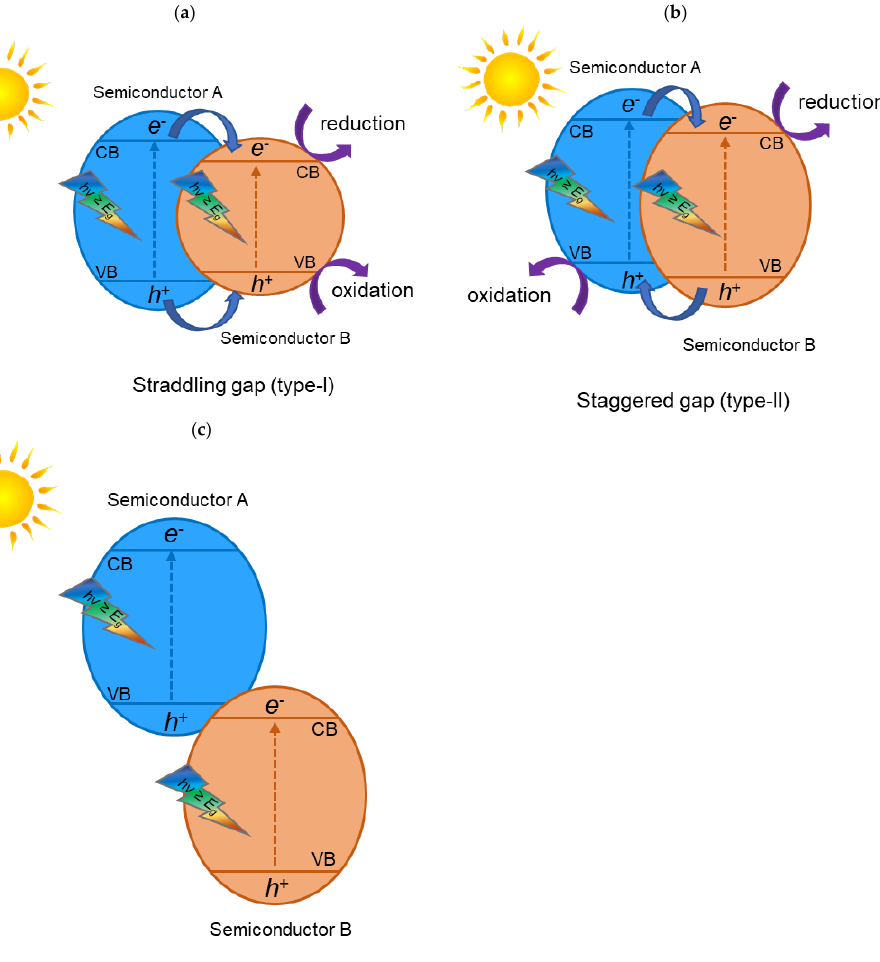
Figure 1. Schematic illustration of the electron – hole separation on an example of heterojunction photocatalyst type-II. Adapted according to refs. [18,19]. A heterojunction is the interface between two diverse materials which has a different band structure, and it can lead to band alignments. Many types of heterojunctions have been studied that are efficient for increasing the photoactivity of materials. These include conventional heterojunctions (type-I, type-II and type-III), surface heterojunctions, p – n heterojunctions, direct Z-scheme heterojunctions, and graphene-semiconductor (gra- phene-SC) heterojunctions [18]. In the conventional heterojunction photocatalysts, there are three types: the type-I have a straddling gap (Figure 2a), type-II have a staggered gap (Figure 2b), and the type-III a broken gap (Figure 2c).